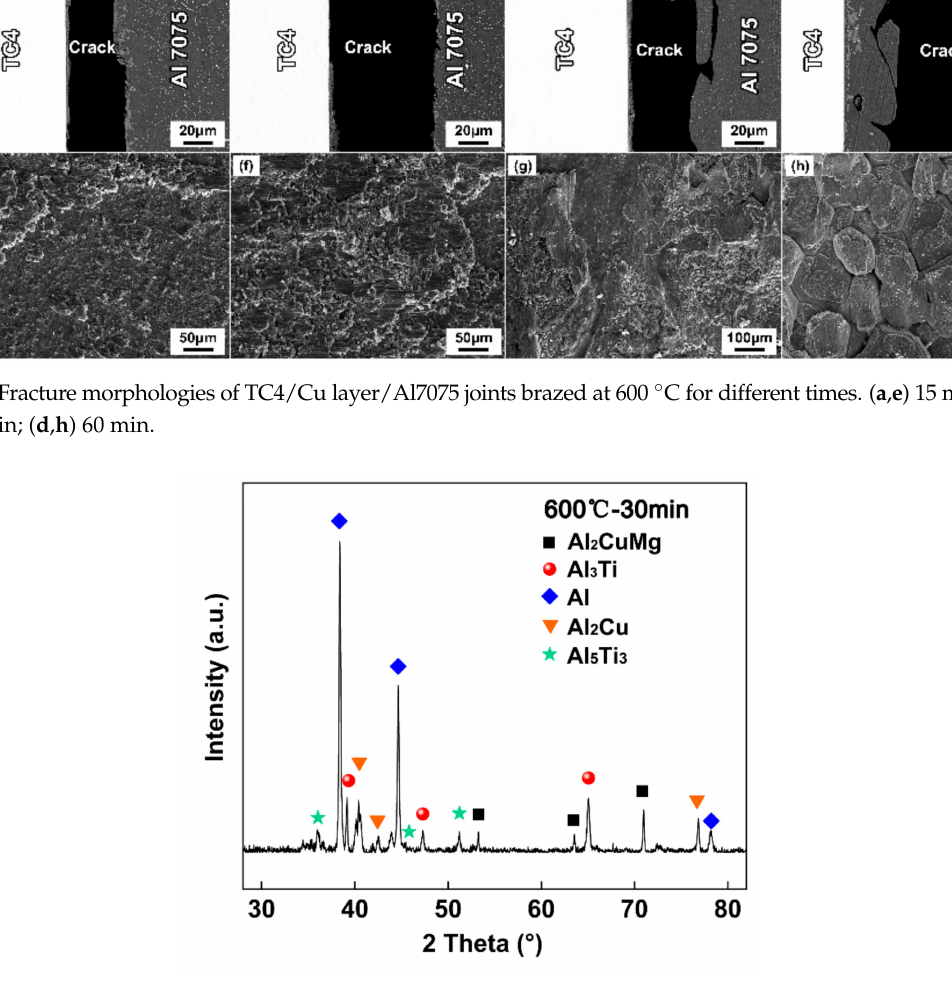
Figure 10. XRD pattern of the fracture surface (Al7075